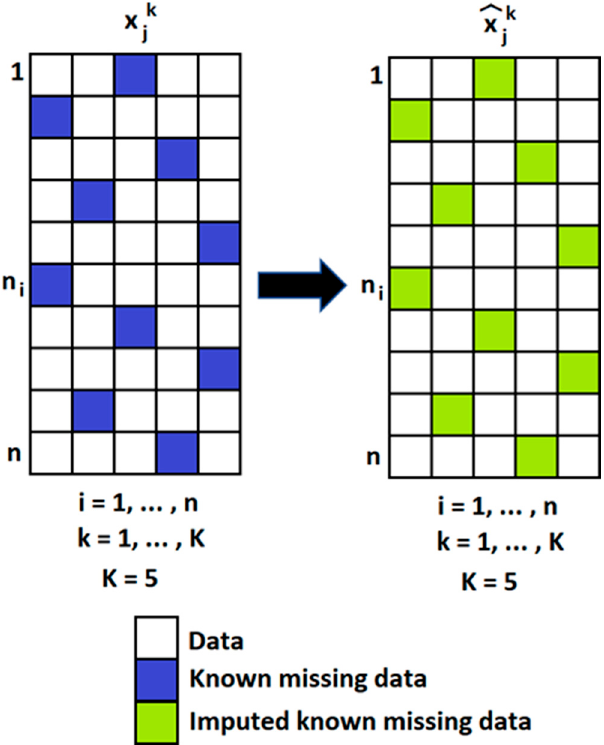
Figure 4. Imputation of known missing values.